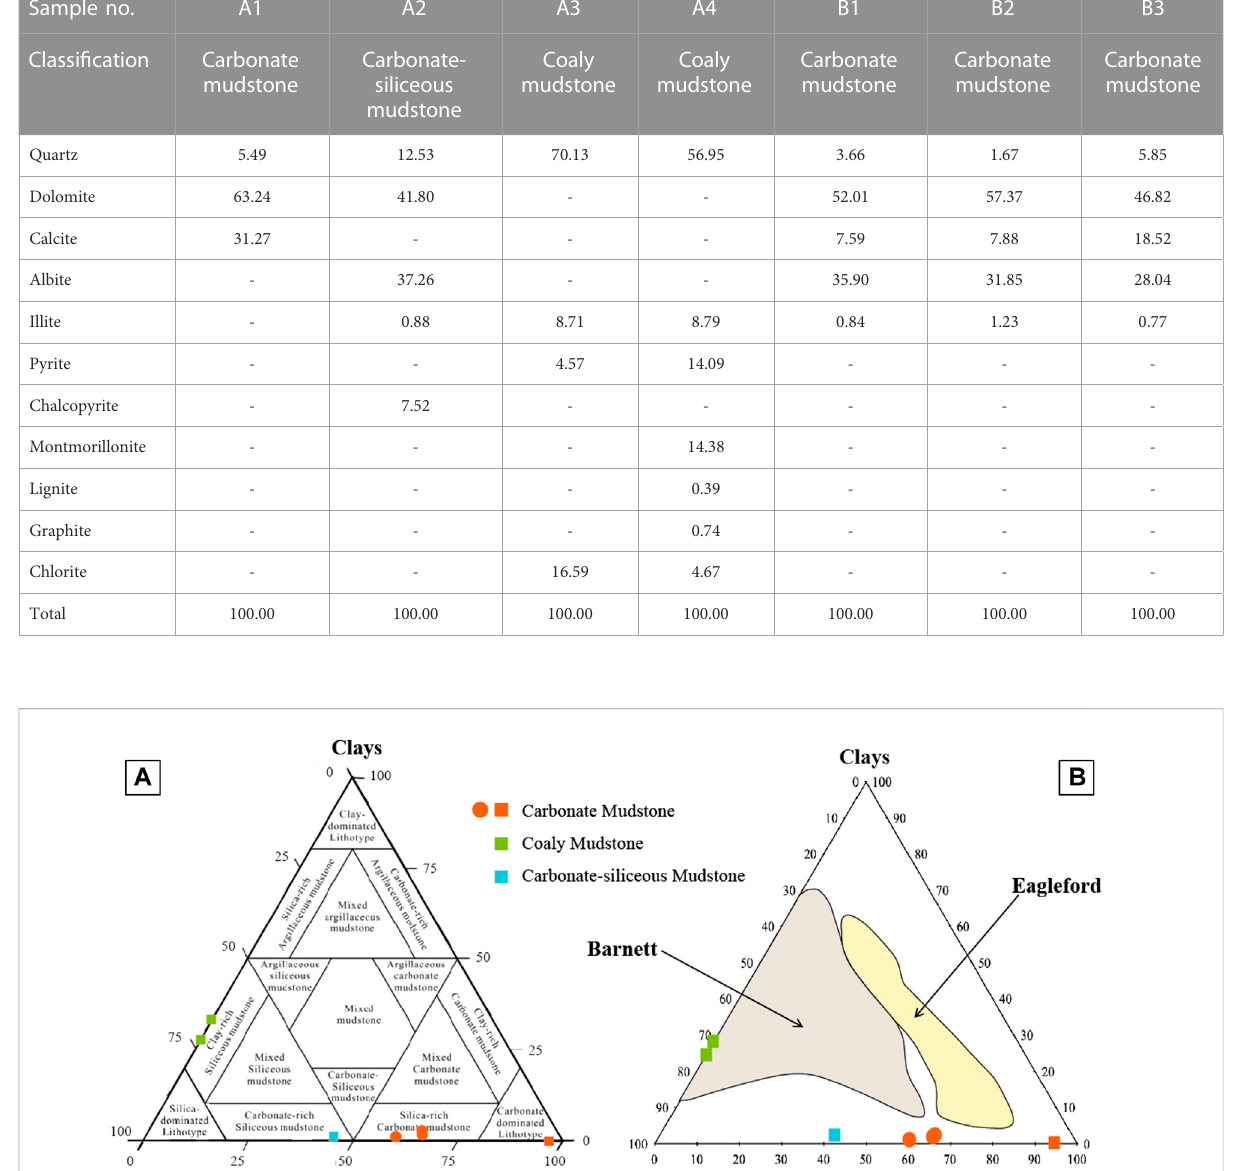
TABLE 1 Mineral assemblages of the rock samples from the Huai Hin Lat Formation. Sample no.